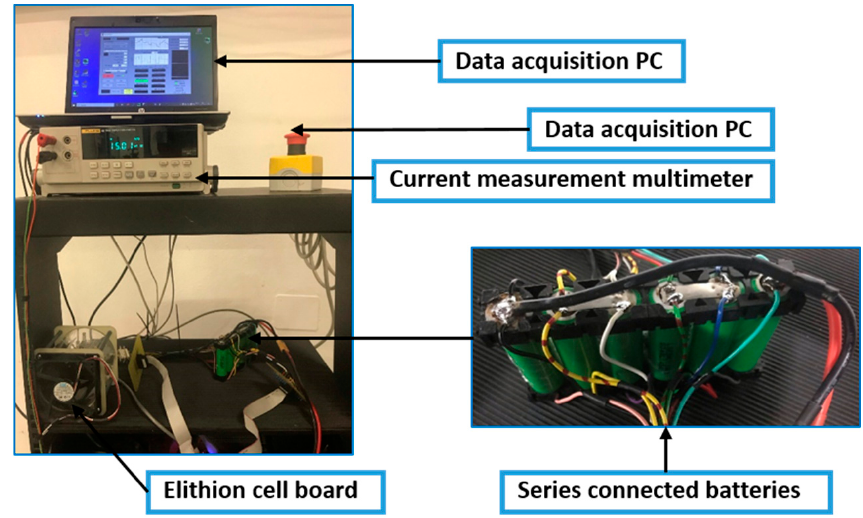
Figure 14. Test bench designed for experimental design and validation of battery electro-thermal model.